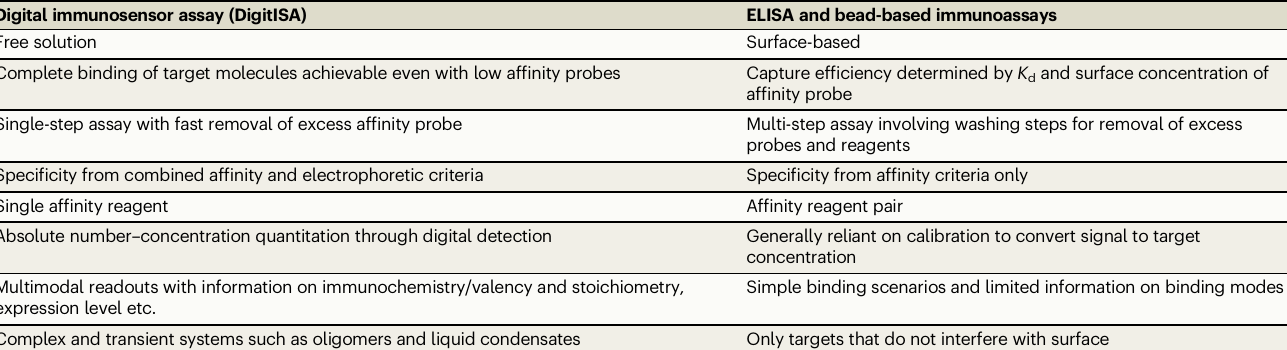
Table 1 | Comparison between the digital immunosensor assay (DigitISA) developed here and conventional surface-based immunosensor assays for protein detection Digital immunosensor assay